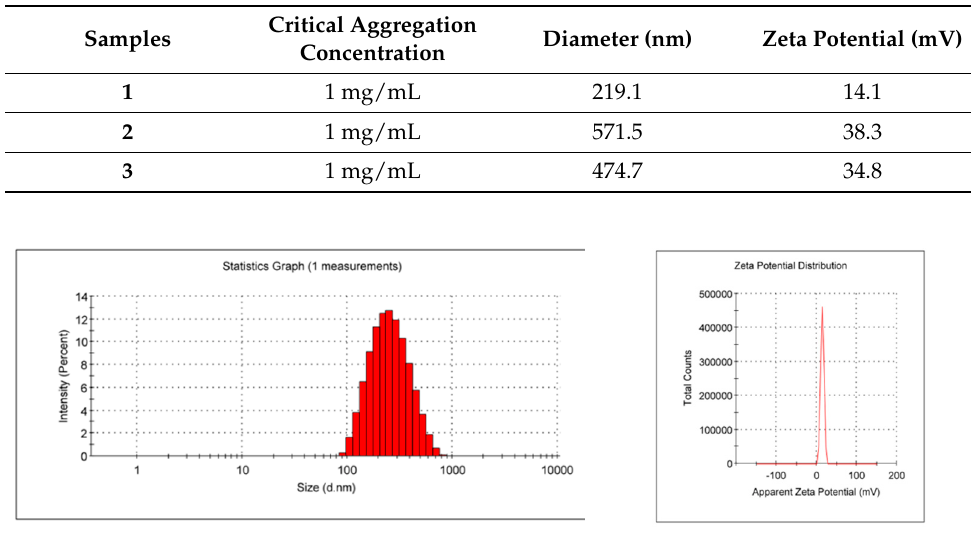
Figure 2. Size distribution and Zeta potential of chitosan Conjugate 1.